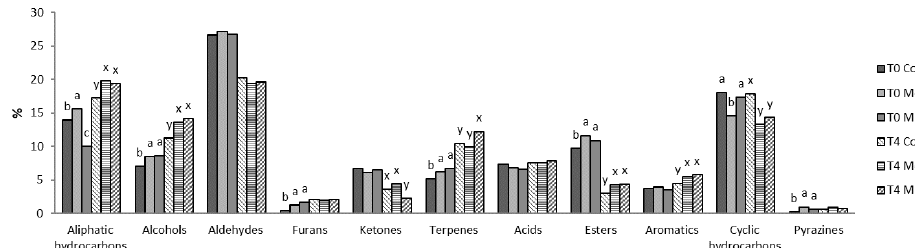
Figure 3. Percentage of families of volatile compounds in cooked sausages. Different letters indicate a significant enrichment effect among batches at T0 (a,b) and T4 (x,y). Co: control batch; Mo: batch with added monolayered fish oil microcapsules; Mu: batch with added multilayered fish oil microcapsules; T0: batch sampled before storing; T4: batch sampled after storing for four months.